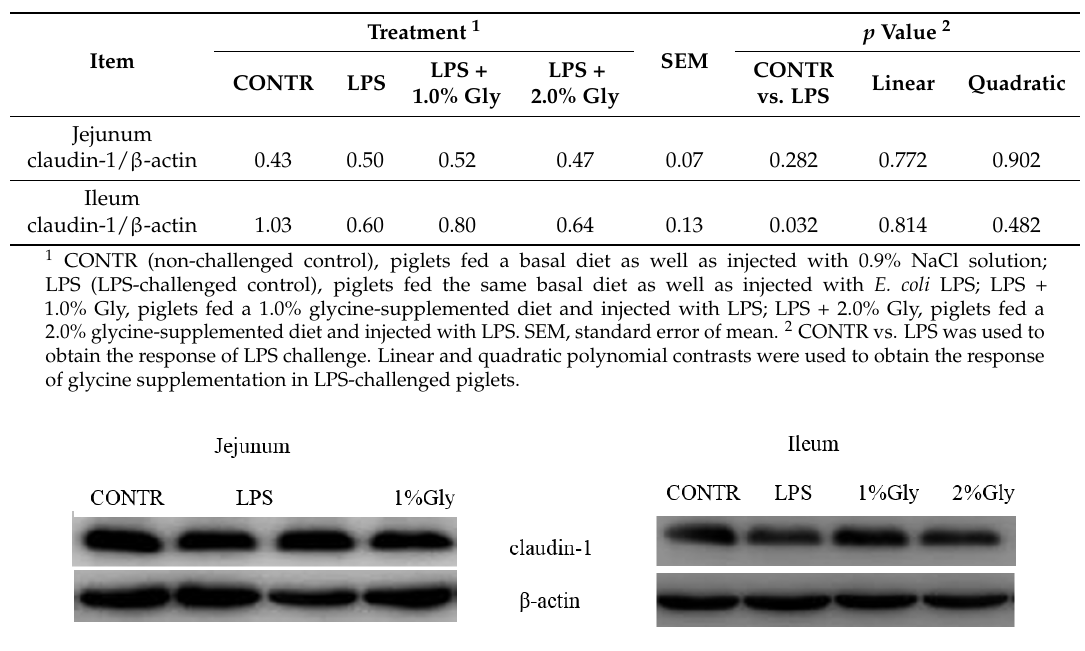
Table 3. Effects of glycine supplementation on intestinal protein abundance of claudin ‐ 1 after 4 h LPS challenge in piglets.